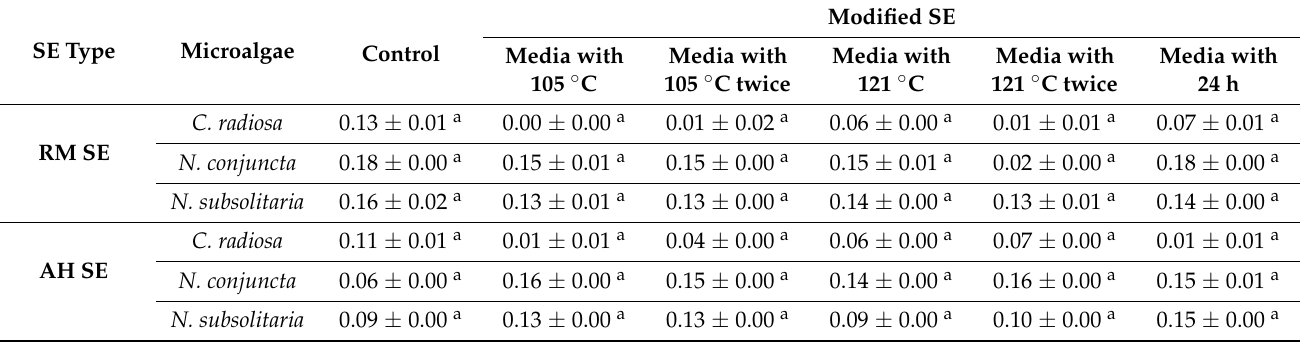
Table 4. The division rate, k , of C. radiosa , N. conjuncta , and N. subsolitaria on control (media without soil extract), 105 ◦ C, 105 ◦ C twice, 121 ◦ C, 121 ◦ C twice, and 24 h SE from RMFR and AHFR.